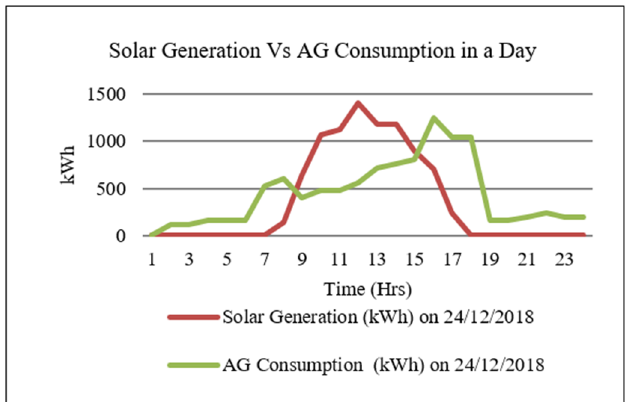
Figure 6. Solar Generation and AG Consumption in a day.